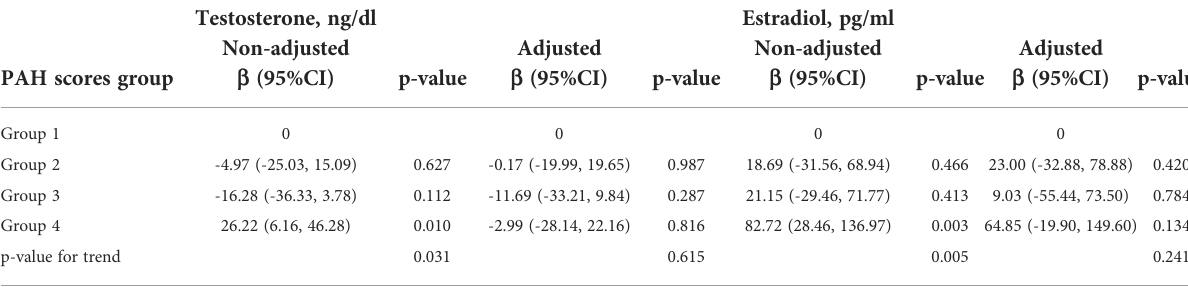
TABLE 4 Relationships between PAHs scores and sex hormones in the non-adjusted and adjusted